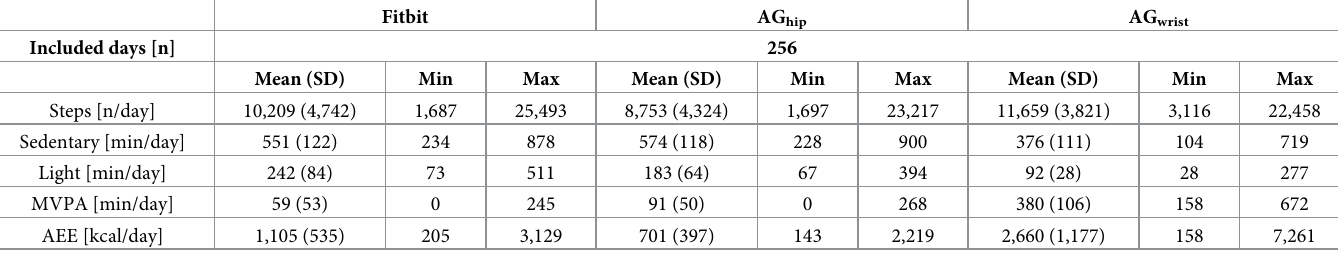
Table 2. Instrument variability.